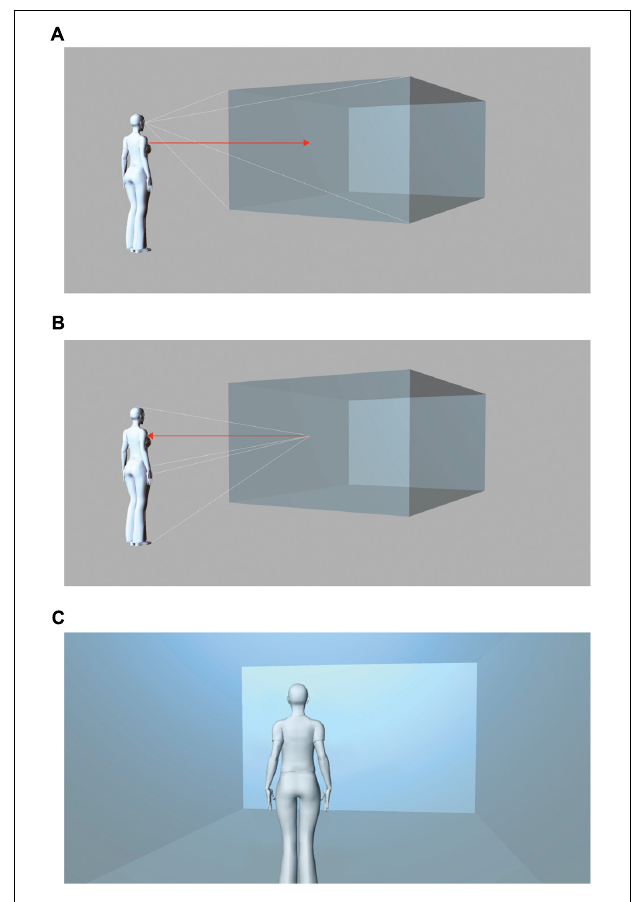
FIGURE 2 | (A) ‘Sympathetic transposition’ of feelings toward form as described by Hermann Lotze and Robert Vischer. (B) ‘Kinesthetic’ reverberation of architectonic form inside the human body after Heinrich Wölfflin. (C) An ‘objectified’ perspective of the observer within space generates a ‘sense of Space,’ as described by August